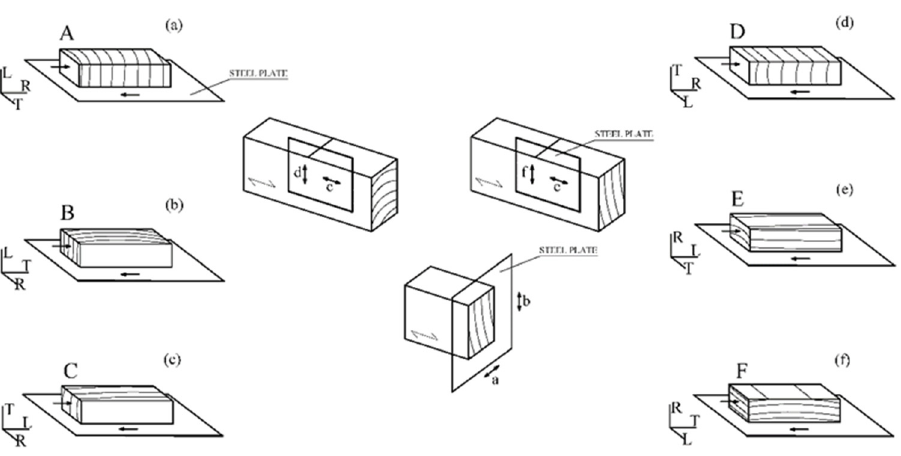
Figure 5. Contact modes studied in mechanical joints. Generated friction tests: ( a ) A–S, ( b ) B–S, ( c ) growth rings; T—tangential to growth rings).